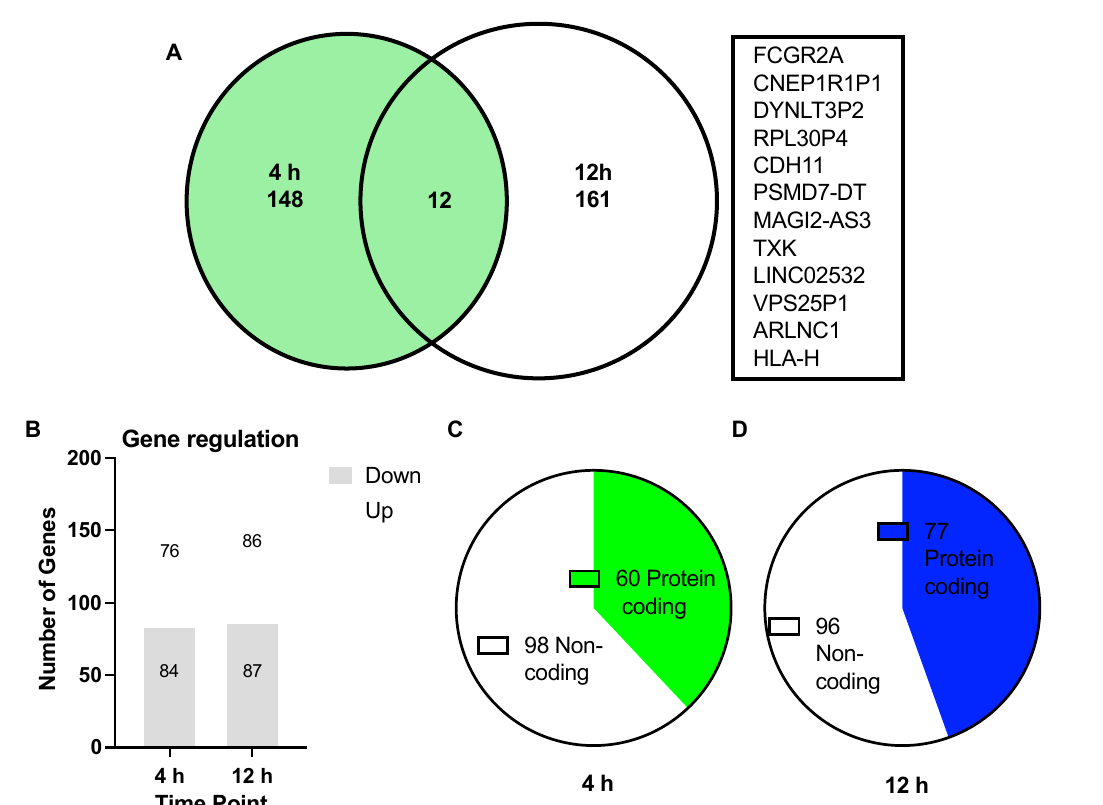
Figure 2. Summary of differentially expressed genes (DEGs) from 4 h (green) and 12 h (blue) data sets, comparing SKOV-3 cells treated with 100 nM of asprosin with non-supplemented controls. ( A ) Venn diagram depicting the number of unique DEGs at 4 h (148) and 12 h (161) with 12 common genes between the overlapping time points annotated to the right of the diagram; ( B ) Bar graph showing the number of up regulated and down regulated DEGs at each time point; ( C , D ) Quantification of coding and non-coding genes for each time point: ( C ) 60 protein coding, with 98 non-coding at 4 h; ( D ) 77 protein coding and 96 non-coding at 12 h.